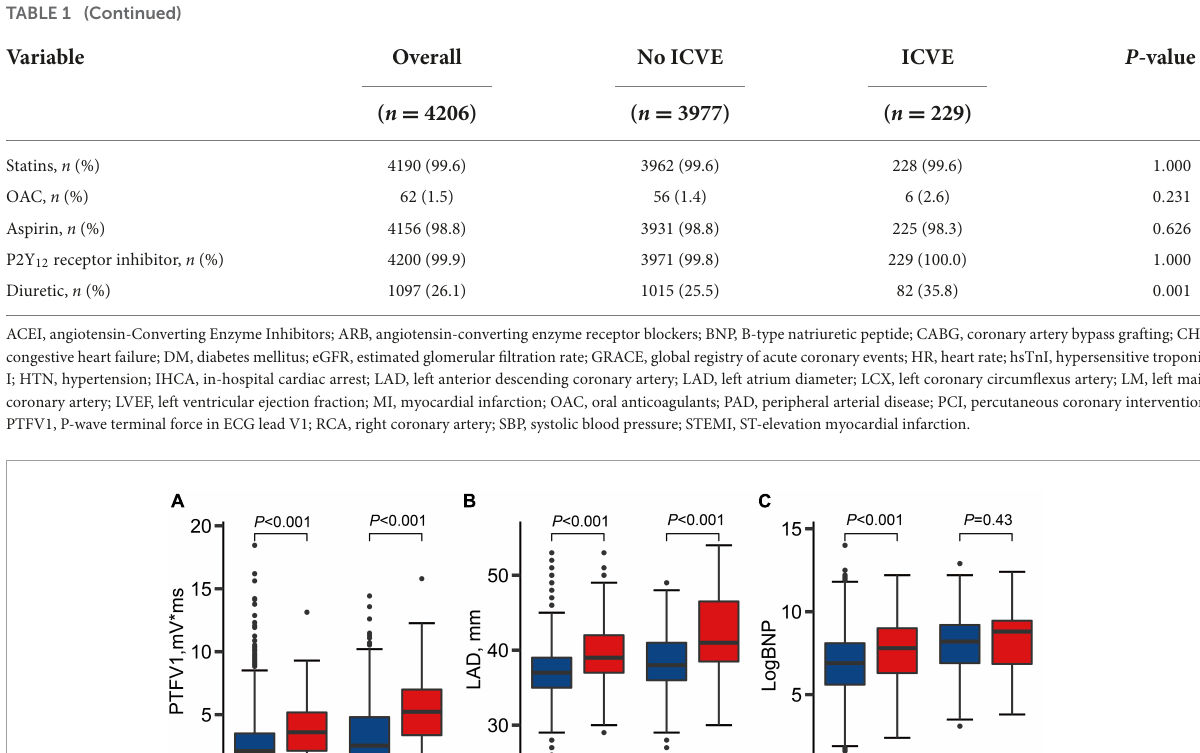
occurrence was attenuated but still remained significant